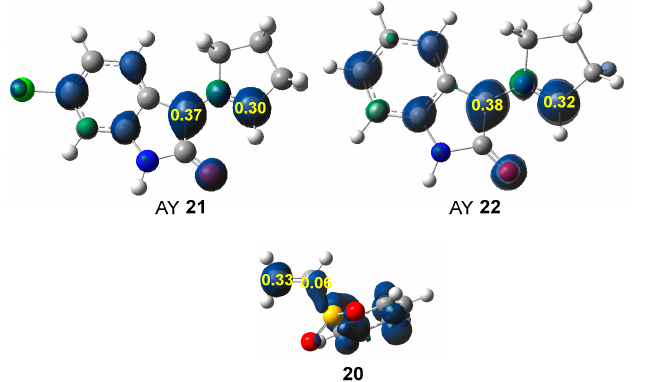
Figure 2. B3LYP/6-31G(d) nucleophilic 𝑃 (cid:3038) (cid:2879) Parr functions of AYs 21 and 22 , and electrophilic 𝑃 (cid:3038)(cid:2878) Parr functions of vinyl sulphone 20 .